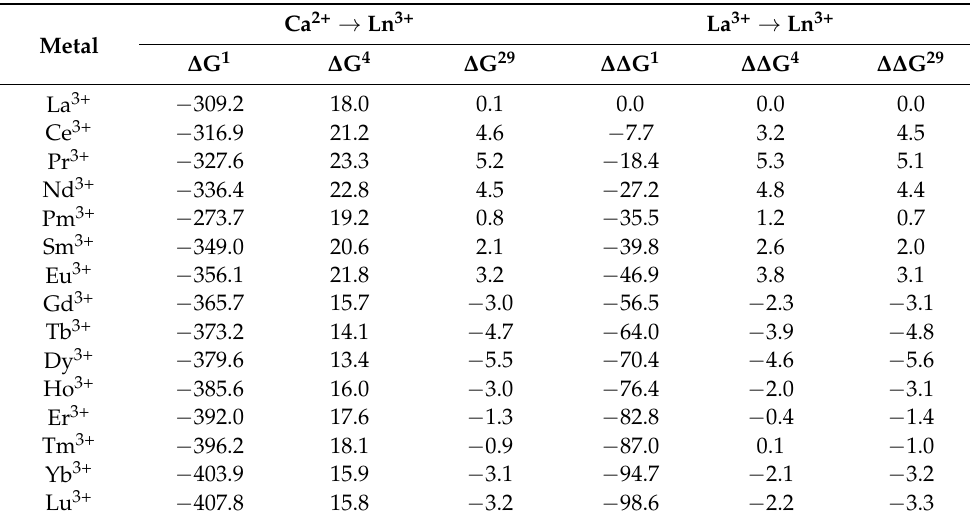
Table 3. Free energies of the Ca 2+ → Ln 3+ and La 3+ → Ln 3+ exchange (in kcal mol − 1 ) for Site 3. Ca 2+ → Ln 3+ La 3+ → Ln Metal